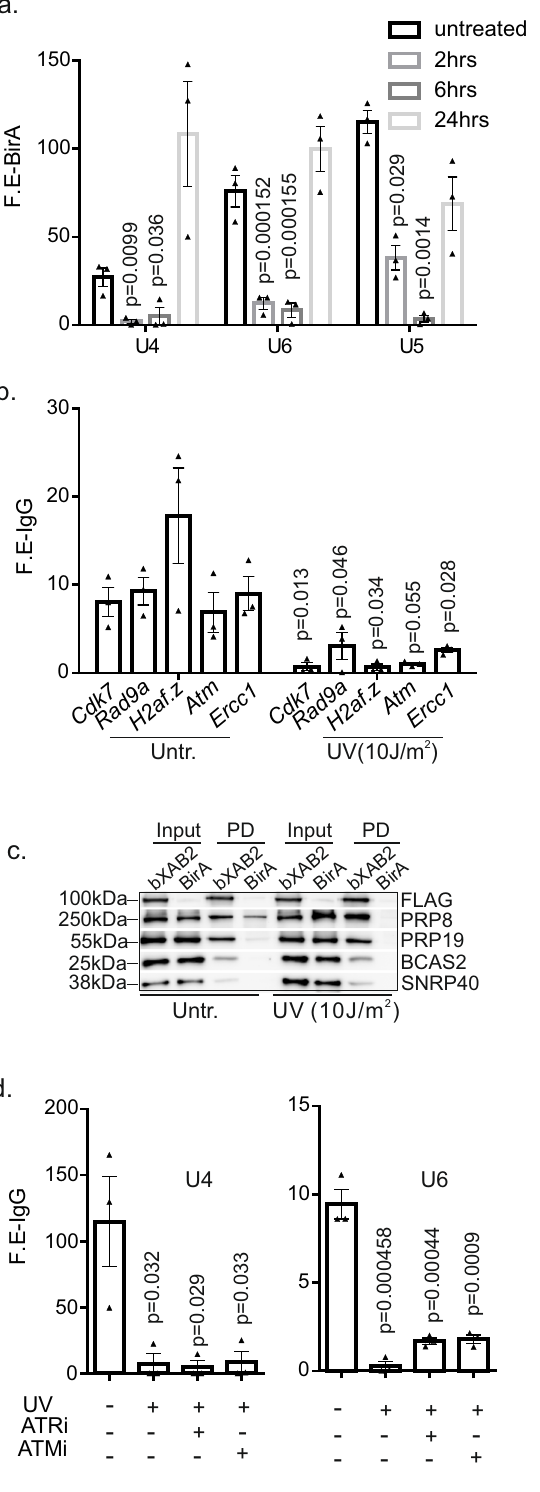
R-loops is frequently observed in cells that are defective in DNA repair or RNA processing 47 – 49 leading to DNA breaks 54 , tran- scription stalling, and DDR activation 77 . In support, we fi nd that R-loops accumulate in primary MEFs following DNA damage or upon treatment with a pre-mRNA splicing inhibitor. Knockdown of Xab2 leads to the substantial increase in R-loop formation and to an R-loop-dependent accumulation of γΗ 2 Α X and 53BP1